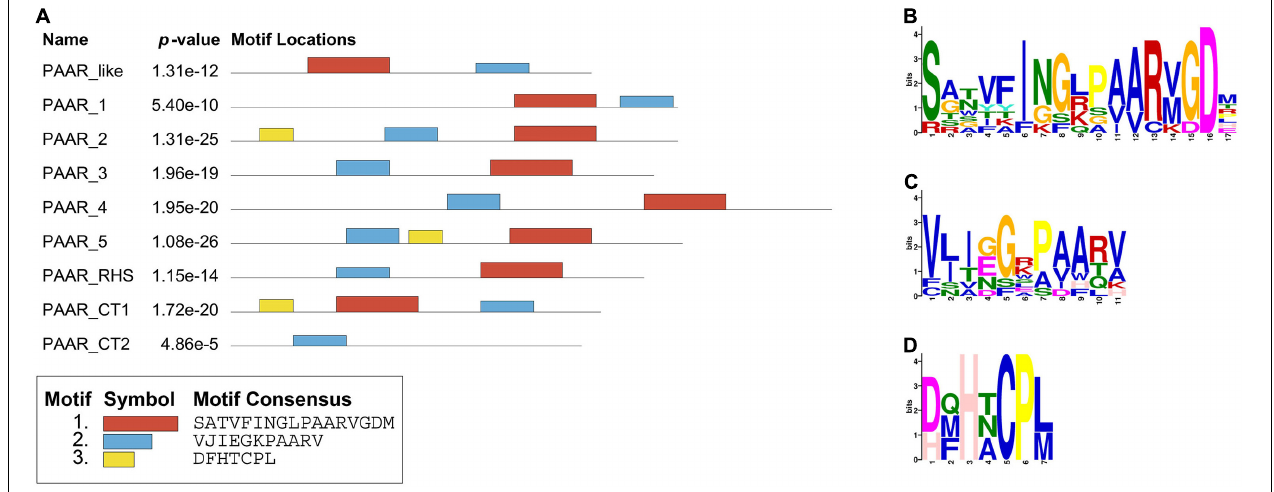
FIGURE 9 | Protein motifs distribution of PAAR_like family members. (A) Motif compositions of PAAR_like family. The distributions of three conserved motifs are represented by different colored boxes. (B–D) Representative conserved amino acids of motifs 1–3. The amino acid position is shown on the X -axis, and the bit-score showing the probability of each of the amino acids at each position is shown on the Y -axis.